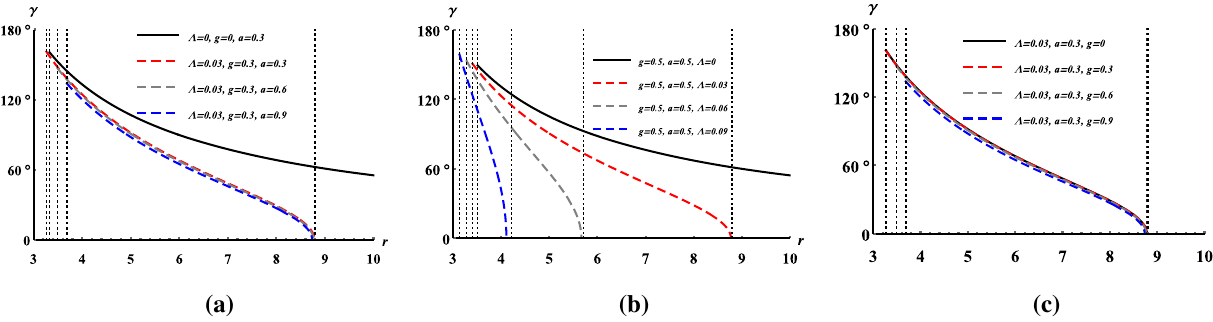
Fig. 6 The angular diameter γ of shadow as a function of the distance from the rotating Hayward–de Sitter black holes for selected parameters, and the observers are located at inclination angle θ = 0. The vertical dotted lines are the outer boundaries and the cosmological horizons. Here we set M =